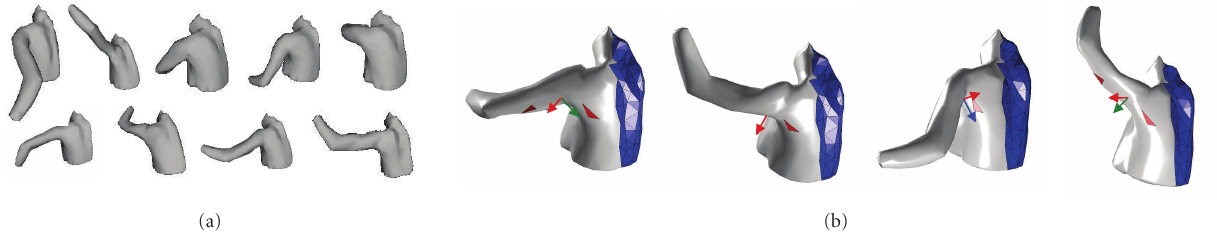
Figure 10: Twisting of the shoulder. We provide 9 examples (a) and are able to obtain natural results using the rotational control (b). The rotational control is more intuitive for controlling shoulder movements than the translational control.